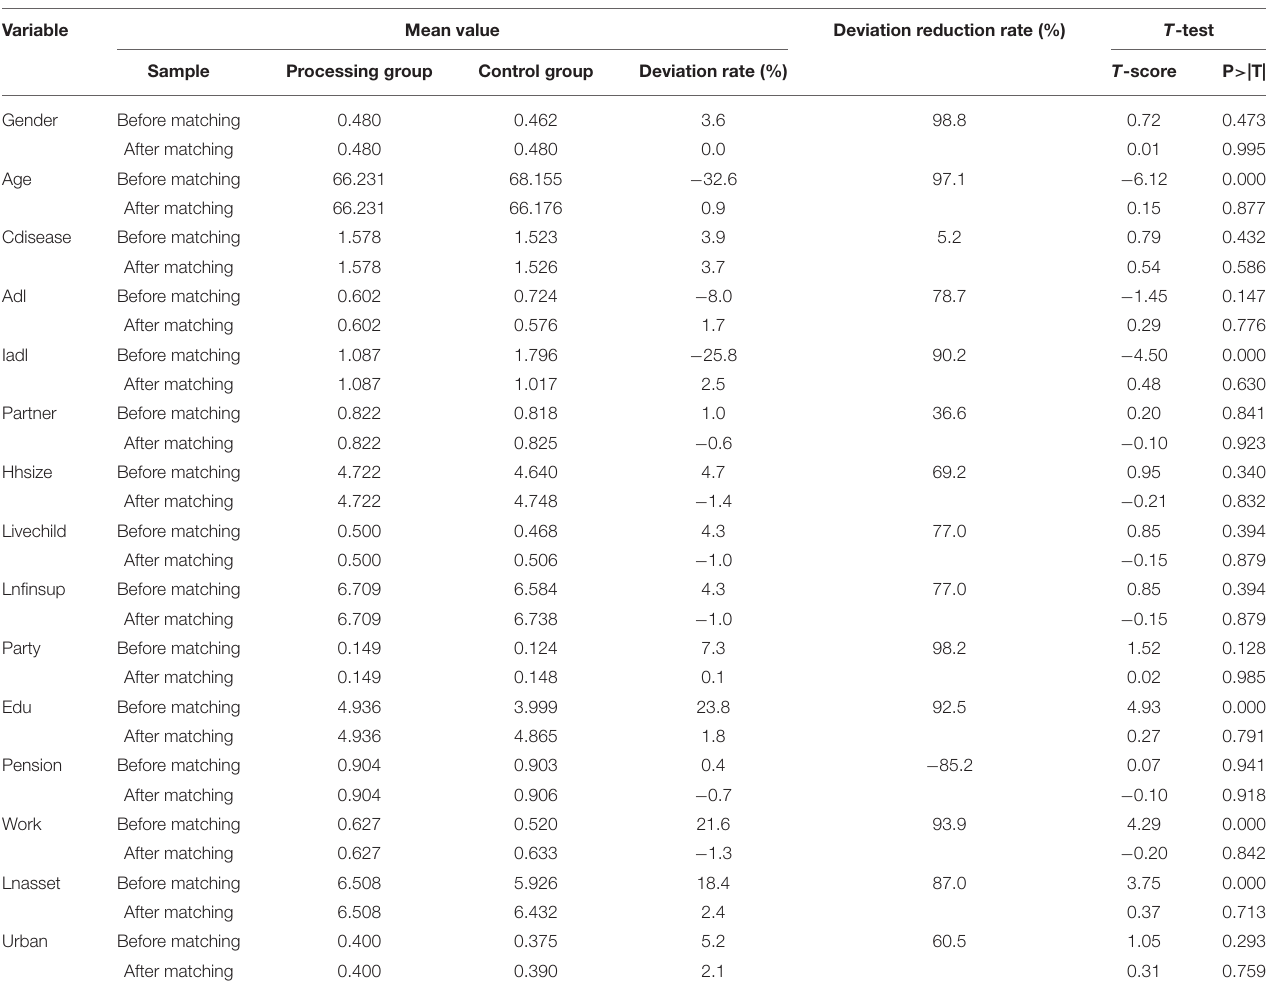
TABLE 4 | Balance test.